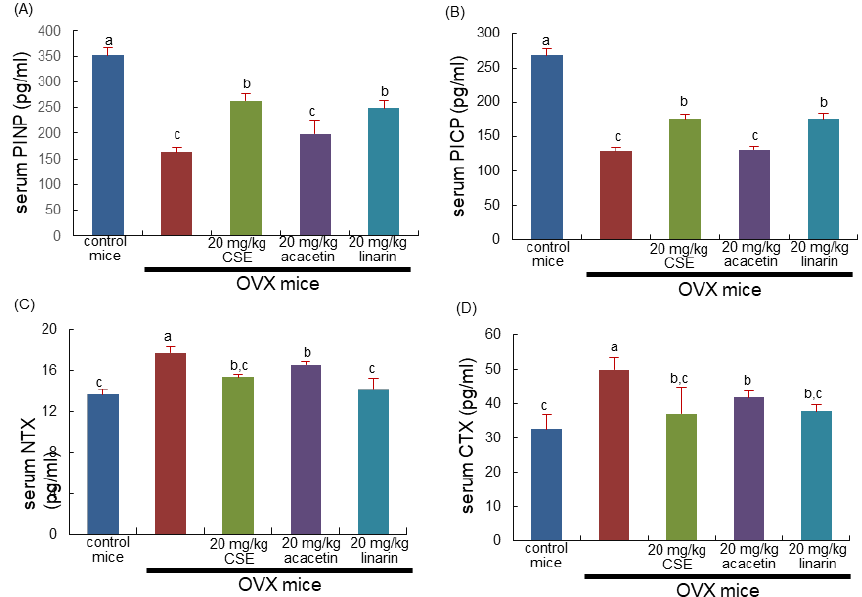
Figure 6. Serum levels of collagen formation and degradation in ovariectomized (OVX) mice treated with Cirsium setidens water extracts (CSEs). OVX mice were orally supplemented with 20 mg/kg CSEs, acacetin, or linarin daily for 8 weeks. The serum levels of procollagen type 1 amino-terminal propeptide (PINP; A ), procollagen type 1 carboxy-terminal propeptide (PICP; B ), amino-terminal telopeptide of type 1 collagen (NTX-1; C ), and carboxy-terminal telopeptide of type 1 collagen (CTX-1; D ) were measured using ELISA kits. Respective values (mean ± SEM, n = 3) in bar graphs not sharing an alphabetical lowercase letter (a, b, c) are different at p <